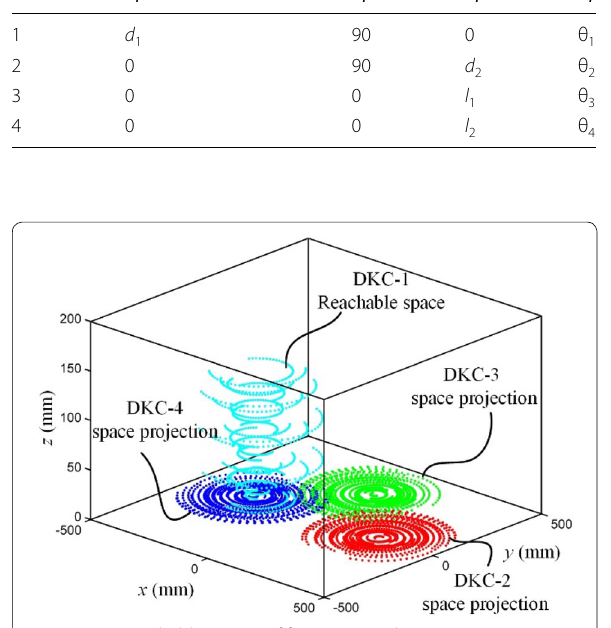
Figure 20 Reachable spaces of four‑arm mechanism